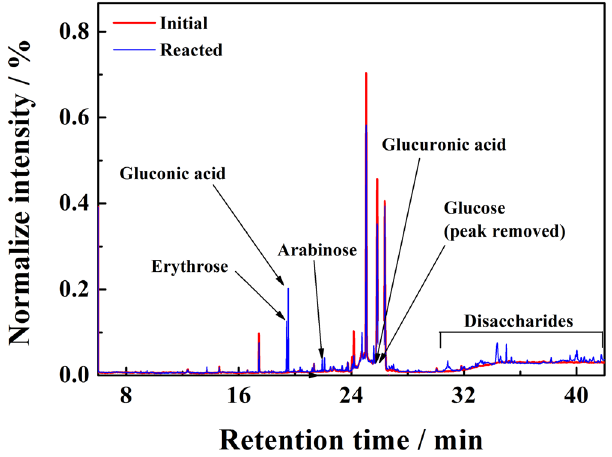
Fig. 5 Chromatogram showing products formed over photoelectrolysis of 0.1 M glucose solution in 0.5M NaCl electrolyte of pH 4. The red trace represents measurement taken before and the blue trace the one performed after 20 h long photoelectrolysis. For the electrolysis conditions see Fig.